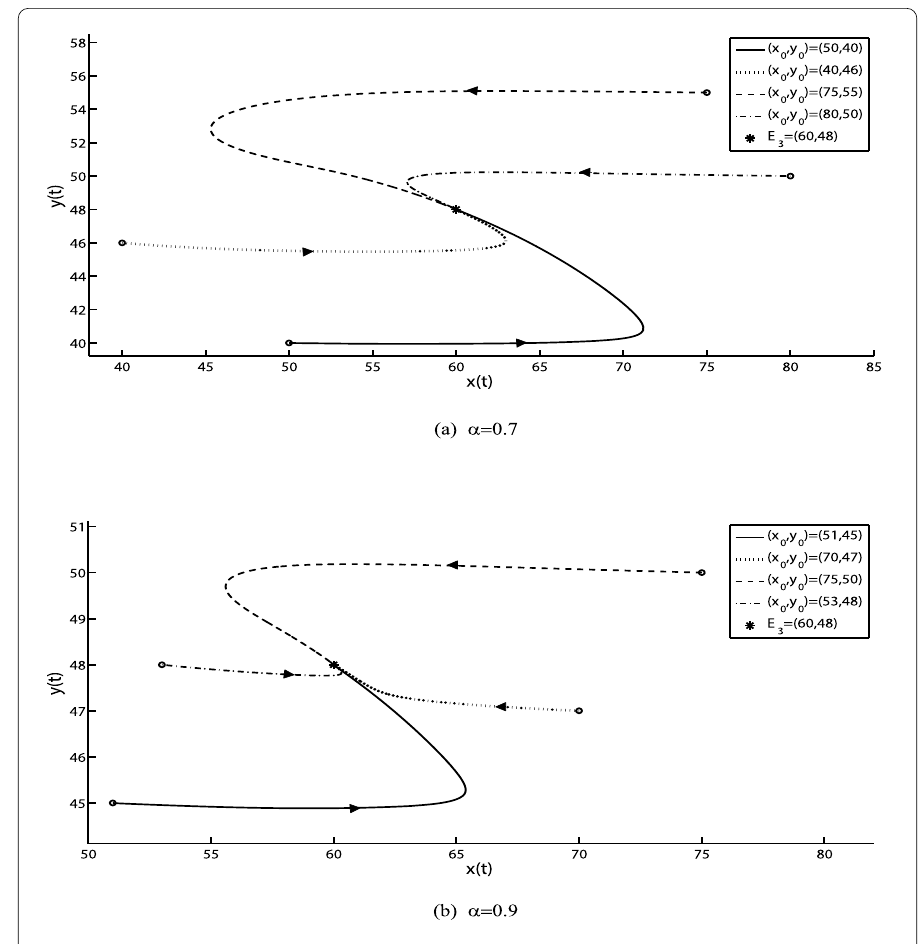
Figure 1 Dynamic behavior of model (3) with several initial conditions and the following parameters: s = 236, r = 4, K = 100, m = 1, a = 60, p = 4, and c = 2. ( a ) Derivative order α = 0.7 and ( b ) derivative order α = 0.9